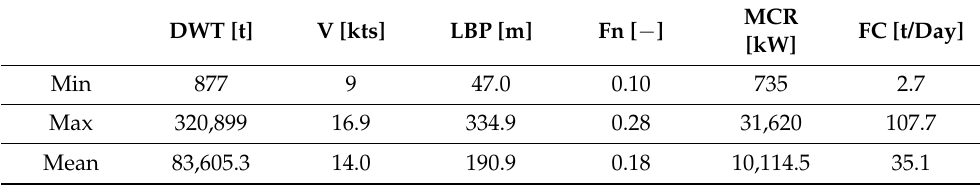
Table 2. Mean, minimum and maximum tanker parameter values, where: MCR—total engine power, FC—daily fuel consumption, DWT—deadweight, V—speed, LBP—length between perpendiculars and Fn—Froude number.